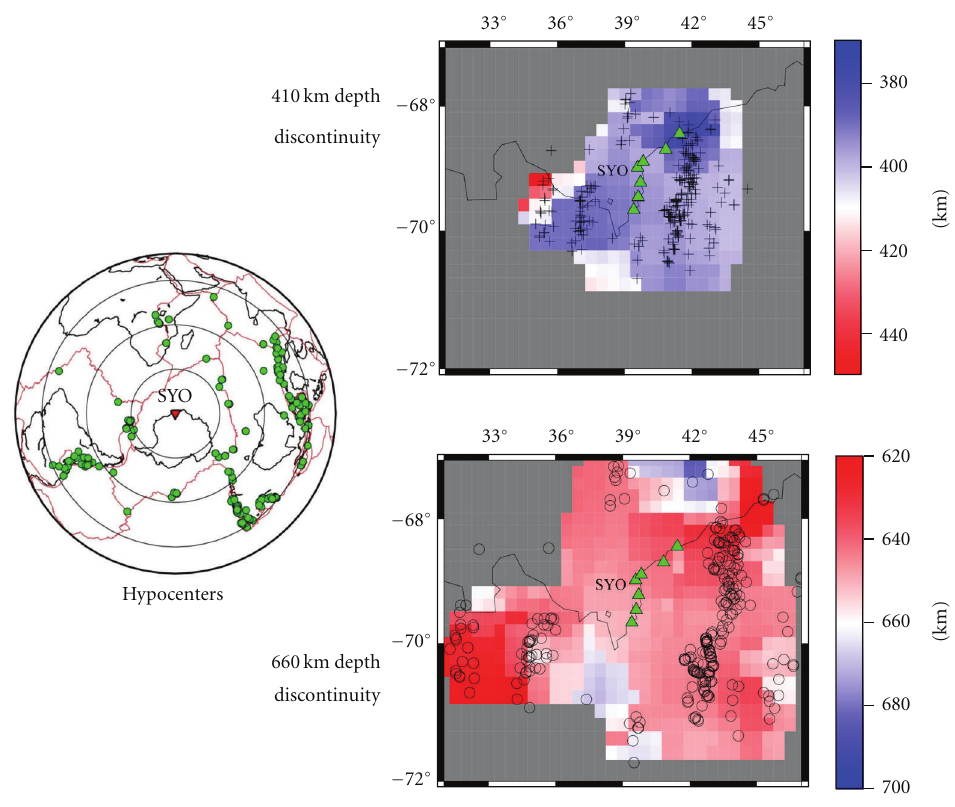
Figure 5: (left) Distribution of hypocenters of teleseismic events used for long-period receiver function analysis (solid circles) and SYO stations (solid triangles). (right) Distribution of P-S conversion depth points for 410 km (upper, crosses) and 660km discontinuity (lower, open circles), respectively. Location of the conversion depth points was obtained by combining GARNET station positions in LHB and hypocenters of the utilized teleseismic events. Topographic depth variations of the upper mantle discontinuities are presented by the color contours (modified after Kanao et al. 2007